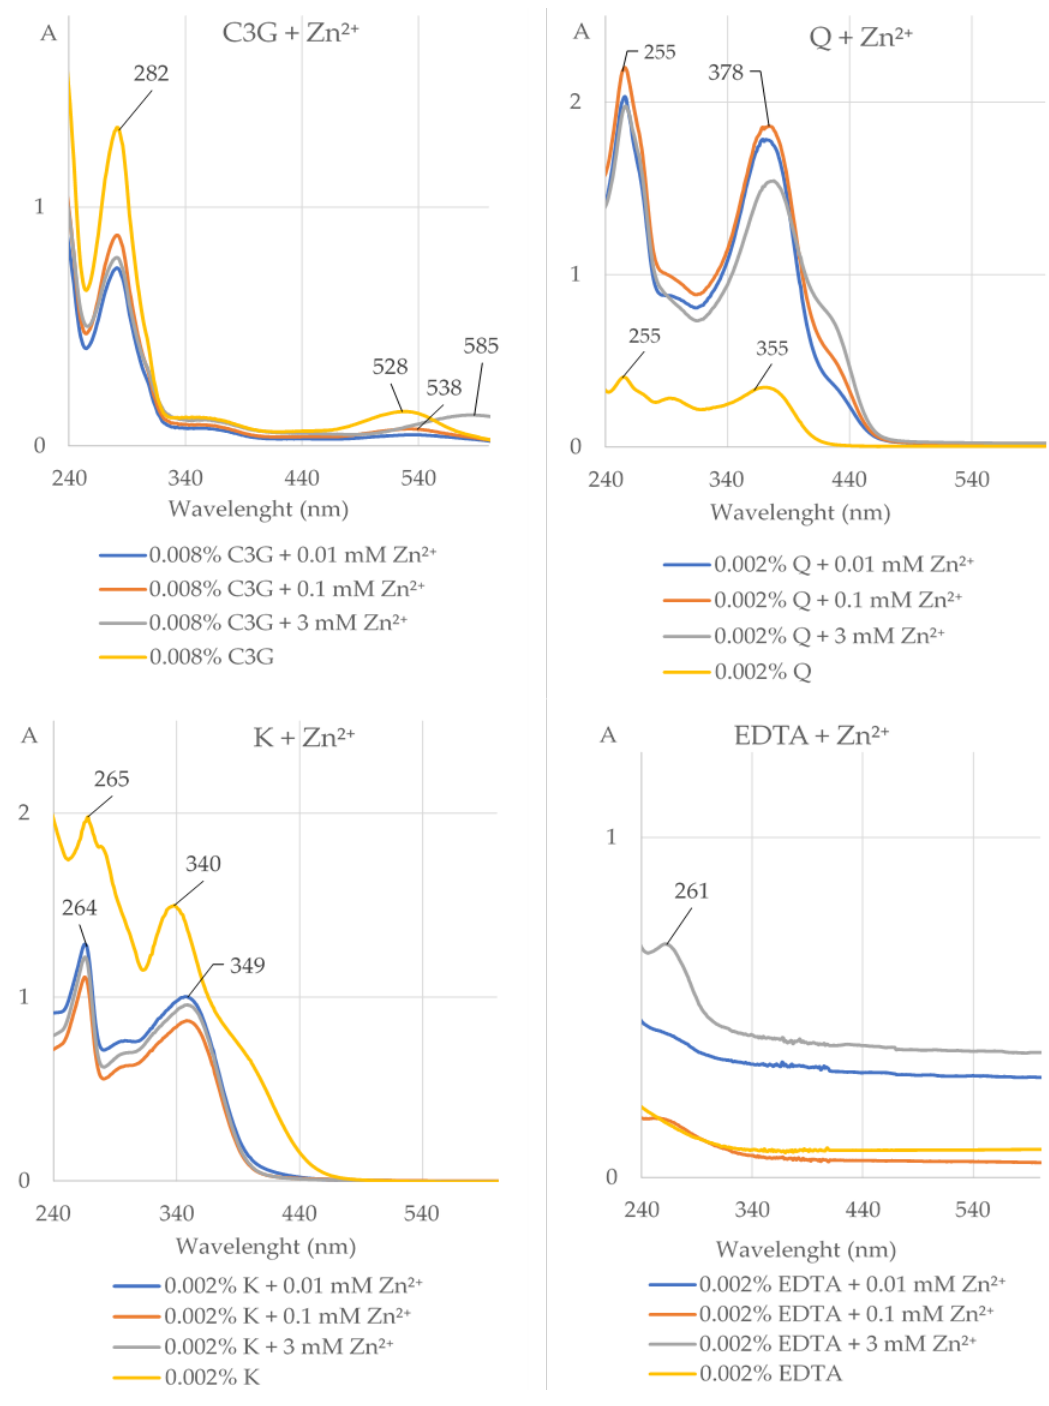
Figure 2. The UV–Vis absorption spectra (with indicated maximum absorption) of cyanidin 3- O-β -galactoside (0.008% C3G), quercetin (0.002% Q), kaempferol (0.002% K), and ethylenediaminetetraacetic acid (0.002% EDTA) alone and after addition of divalent ions of zinc (Zn 2+ ) at the concentrations of 0.01, 0.1, and 3 mM at pH 5.5. The shift of the maximum absorption after addition of Zn 2+ to the solution of the investigated compound indicates that this compound chelated these ions. A, absorbance.